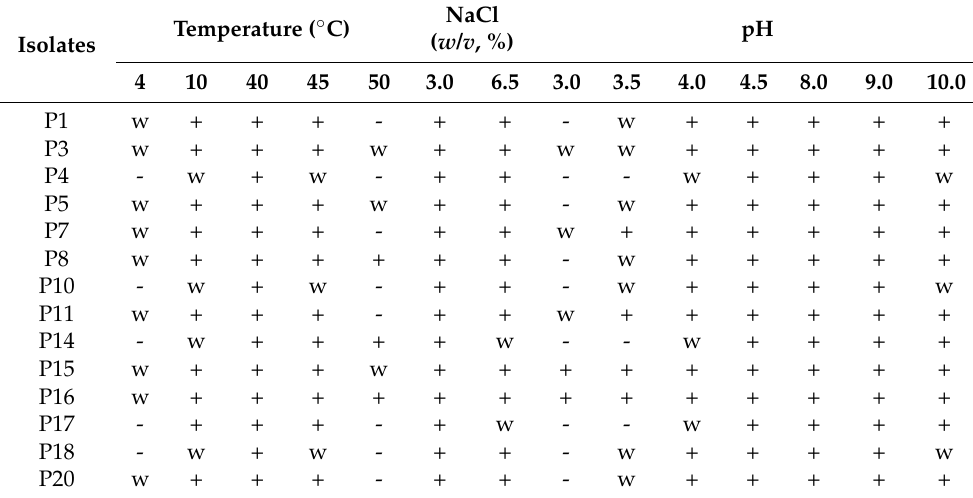
Table 3. Physiological and biochemical characteristics of representative LAB isolates.